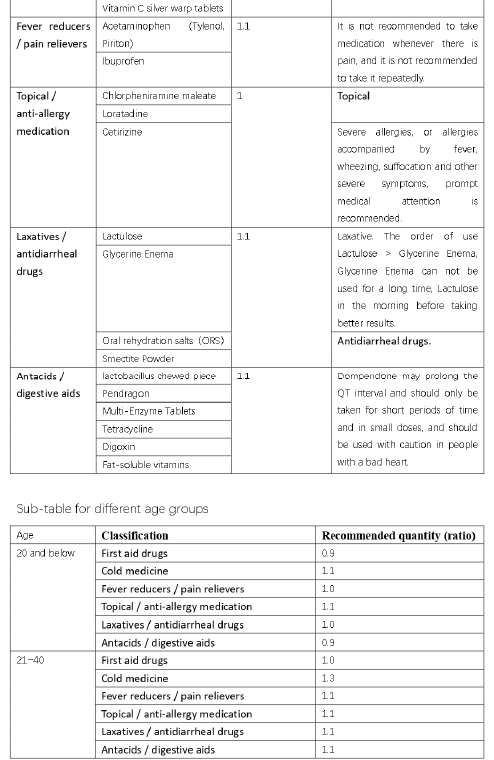
Figure 13. The initial version of the system.